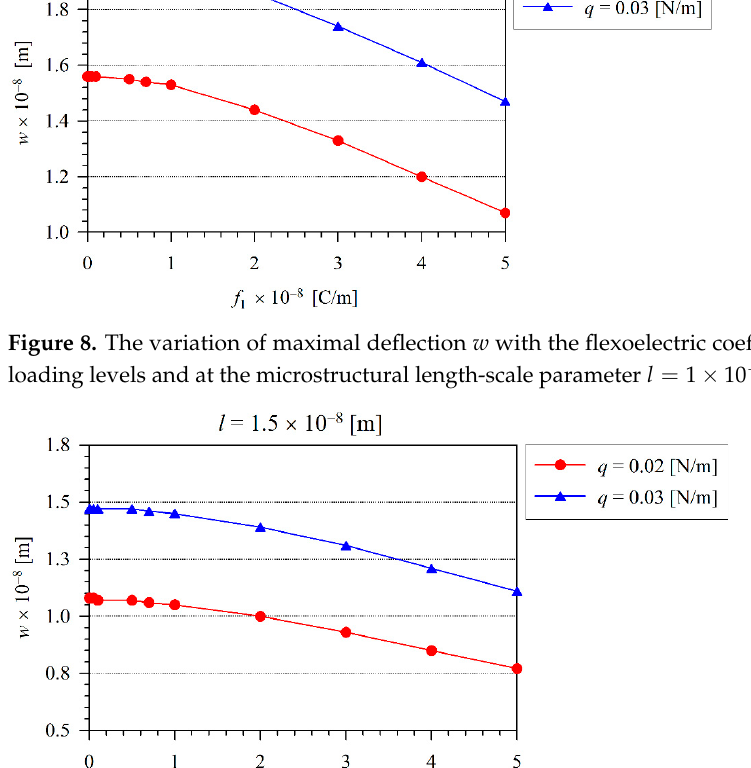
with the increasing value of the flexoelectric coefficient.